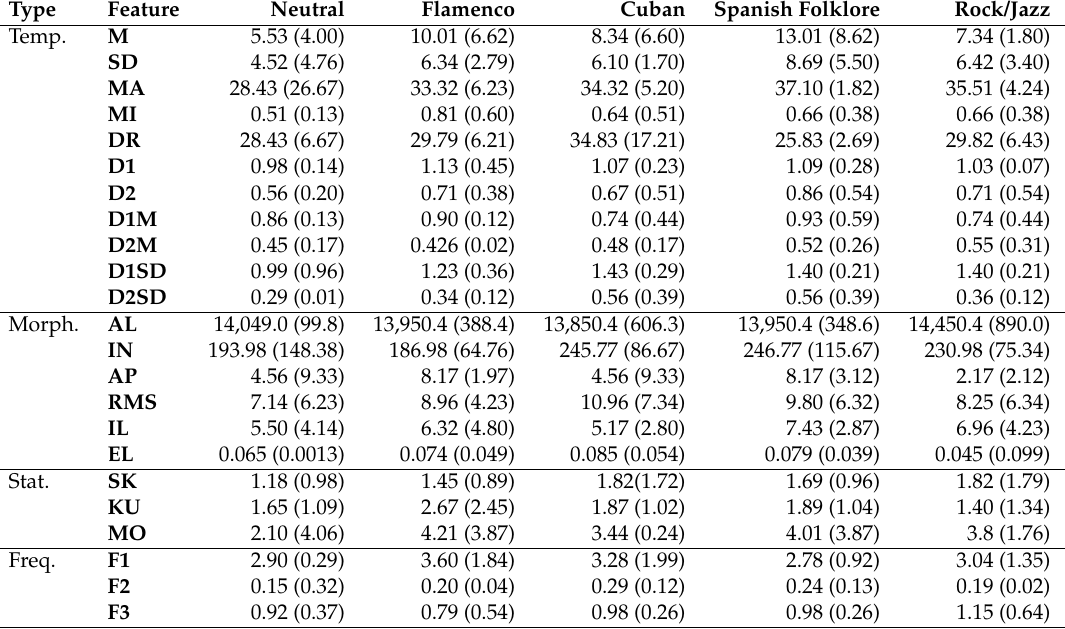
Table 3. Mean and standard deviation for the different